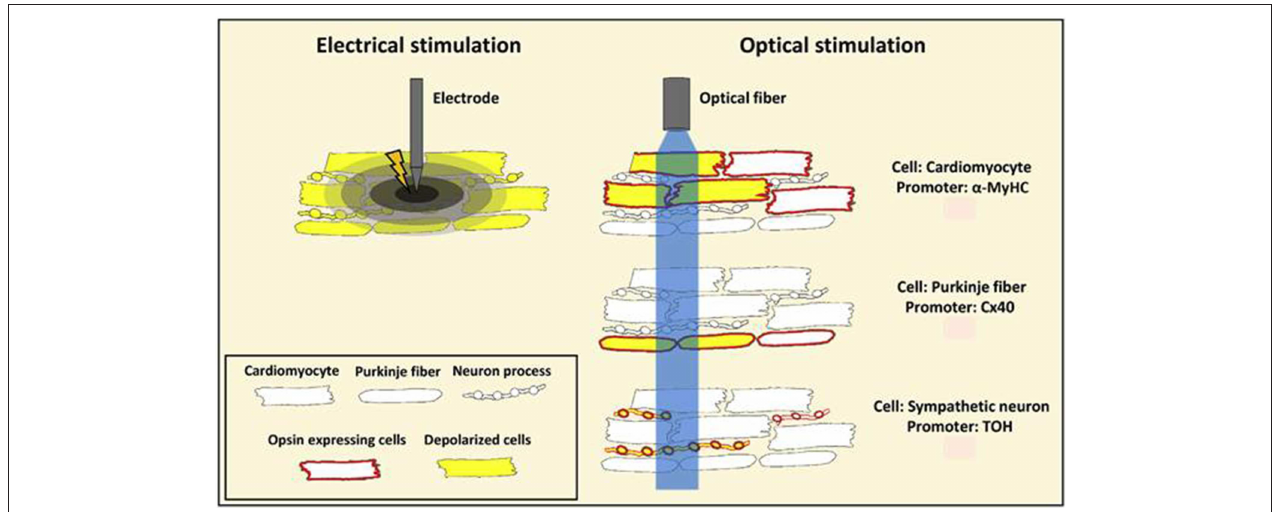
FIGURE 5 | A schematic representation showing benefits of optogenetic stimulation over conventional electrical stimulation. Conventional electrical stimulation results in an unspecific depolarization of myocardial cells, including nerve fibers, within the stimulated tissue volume resulting in pain and tissue injury. Optogenetics provides restricted stimulation to opsin-expressing cells. Listed in the figure are cell-specific promoters Myosin Heavy Chain (MyHC), Connexin 40 (Cx40), and Tyrosine Hydroxylase (TOH) that are used for targeted stimulation of opsin expressing cardiomyocytes, Purkinje fibers and sympathetic neurons, respectively. Reproduced and adapted with permission from Pianca et al.